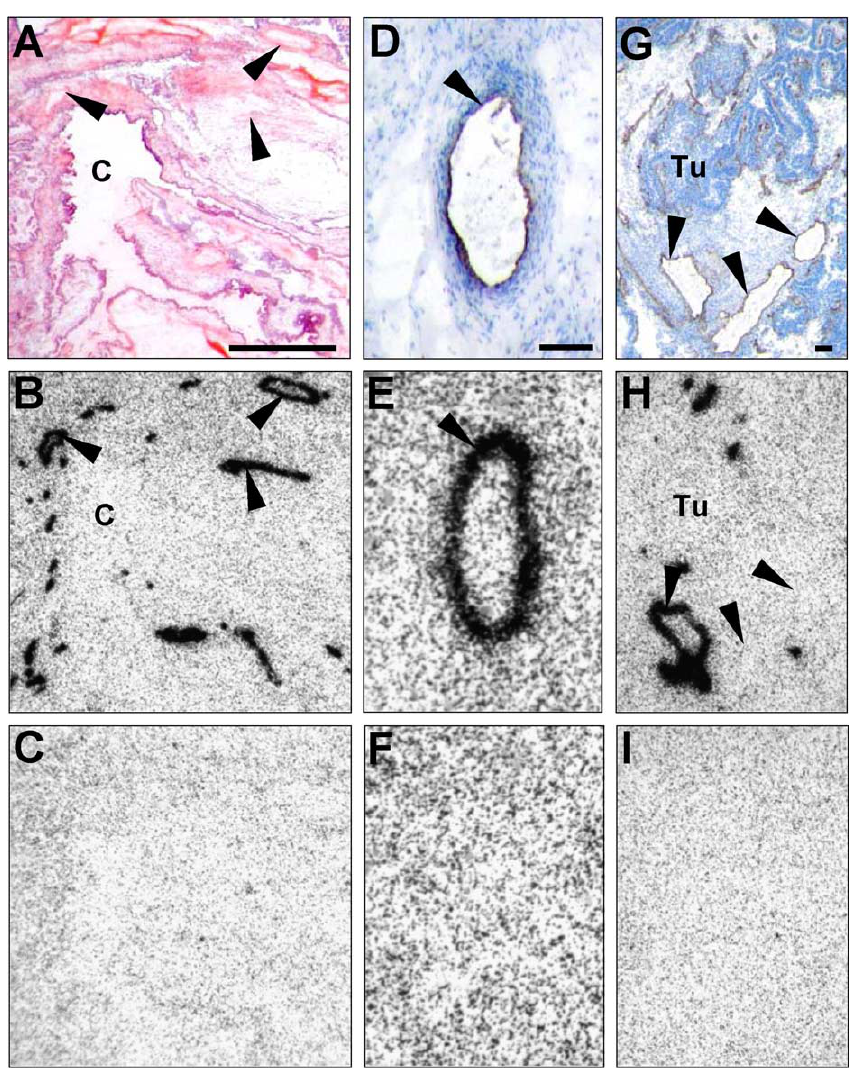
Fig. 2. Detailed features of GRP-receptor positive tumoral blood vessels. A: H&E-stained section of a mucinous borderline tumor with epithe- lial lined cysts (c) in a tumor stroma with numerous blood vessels (three indicated by arrowheads); bar = 1 mm. B: autoradiogram showing total binding of 125 I-[Tyr 4 ]-bombesin. Several blood vessels are labeled (three indicated by arrowheads), mostly appearing as small black dots or as black lines and tubular segments with open lumina. The neoplastic cells lining the cysts (c) are not labeled. C: control section showing non-specific binding. D: immunohistochemically (Factor VIII) stained section of a mature tumoral blood vessel (arrowhead) with a muscular wall and a brown labeled endothelium; bar = 0.1 mm. E: autoradiogram showing total binding of 125 I-[Tyr 4 ]-bombesin. The vessel wall (arrowhead) is homogeneously circumferentially and transmurally labeled. F: control section showing non-specific binding. G: immunohistochemically (Fac- tor VIII) stained section of a serous carcinoma (Tu) with several large tumor vessels (arrowheads) showing brown labeled endothelium; bar = 1 mm. H: autoradiogram showing total binding of 125 I-[Tyr 4 ]-bombesin. Only one of the large vessels (arrowheads) and further smaller vessels are labeled. No labeling of the neoplastic tissue (Tu). I: control section showing non-specific